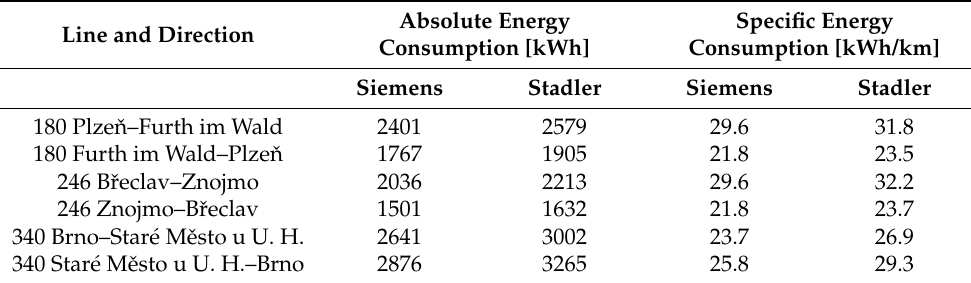
Table 13. Specific traction energy consumption [kWh/km] for the proposed train paths. Source: